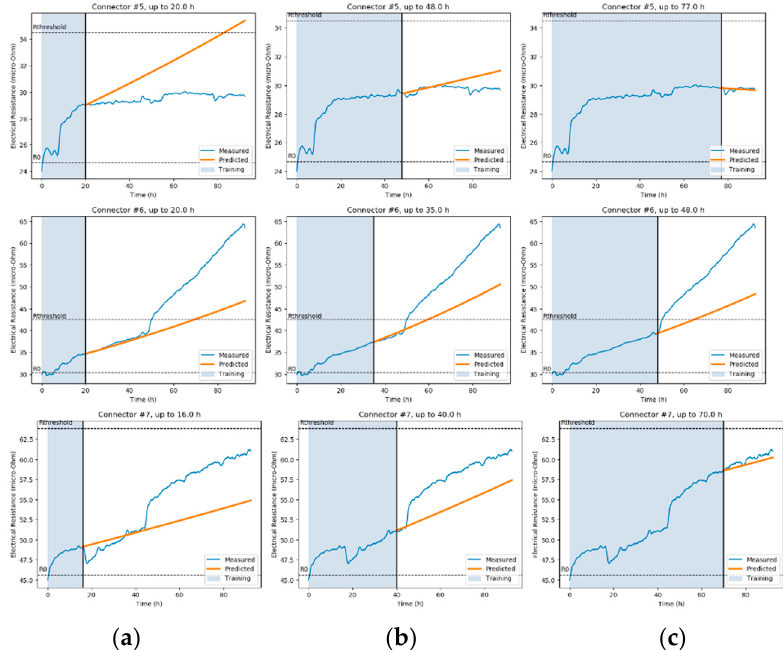
Figure 5. Autoregressive (AR) ( p = 3) RUL prediction of the analyzed connectors (#1 to #7) for time instants ( a ) 1, ( b ) 2, and ( c ) 3.